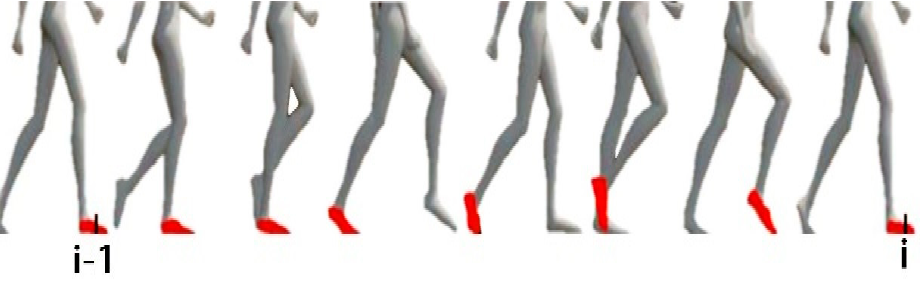
Figure 1. Movement status and the corresponding